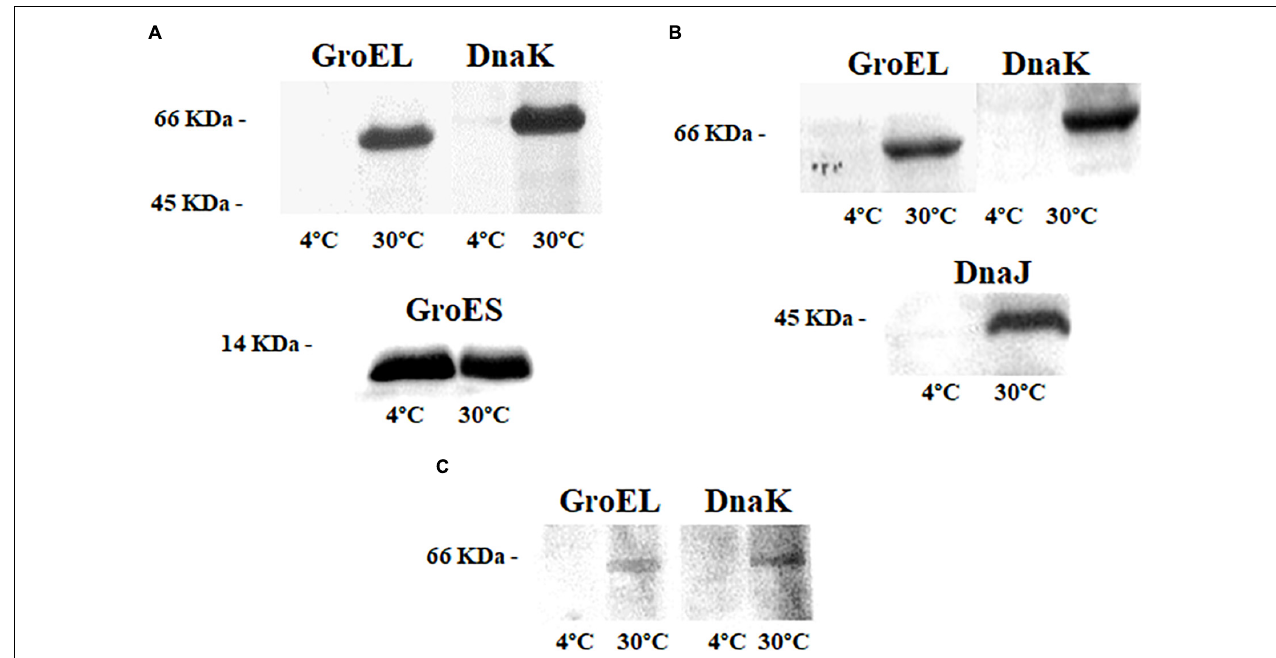
FIGURE 2 | Immunodetection of chaperones in the cell extracts of the three bacteria at 4 and 30 ◦ C; (A) GroEL, DnaK, and GroES in Shewanella oneidensis ; (B) GroEL, DnaK, and DnaJ in Shewanella frigidimarina ; and (C) GroEL and DnaK Psychrobacter frigidicola